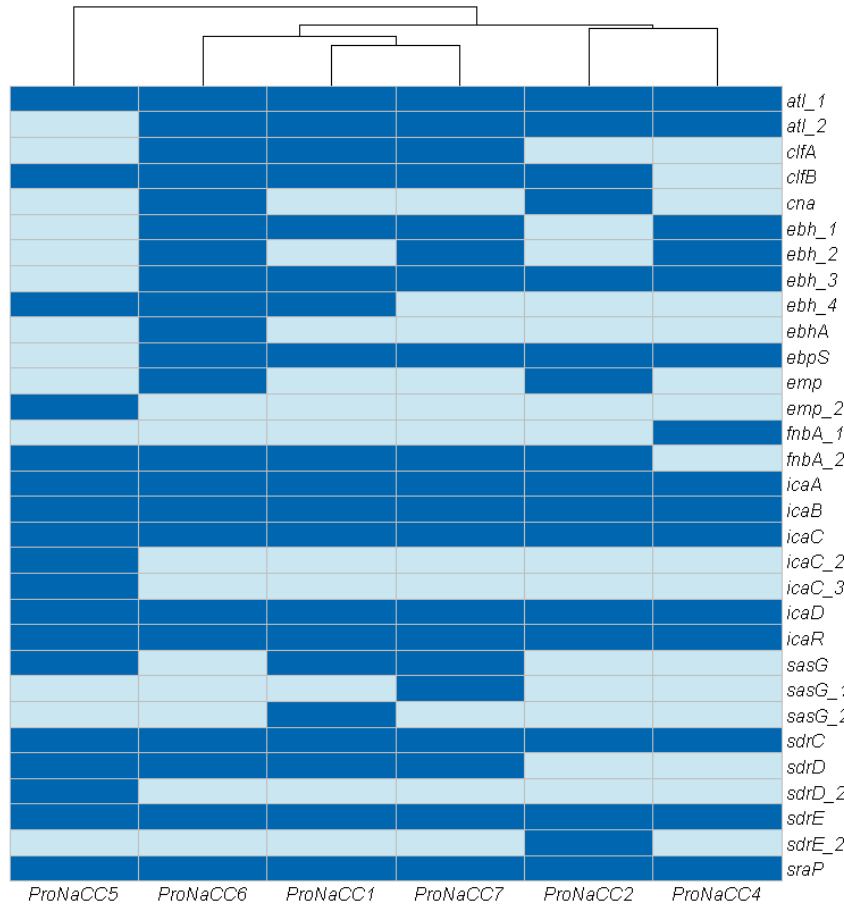
Figure 2. Heat map showing the adherence factors distribution among the six enterotoxigenic S. aureus strains (dark blue: sequence detected; light blue: sequence not detected).